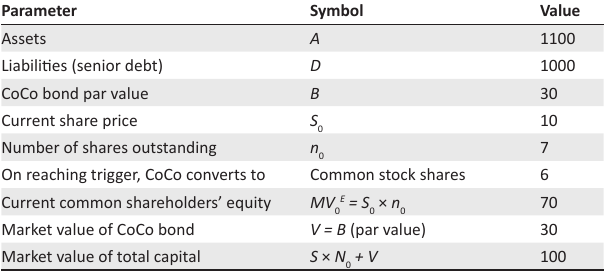
TABLE 4: Assumptions underlying a numerical contingent convertible debt example. Parameter